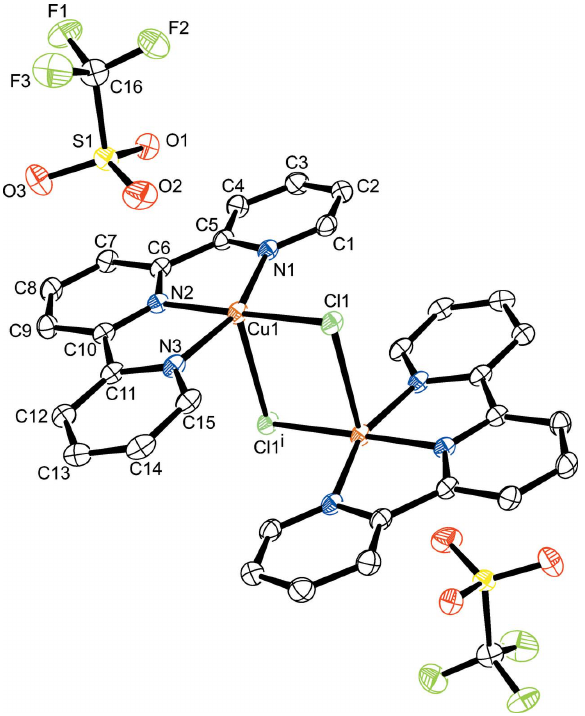
Figure 1 The molecular structure of the title compound with displacement ellipsoids drawn at the 50% probability level; H atoms are omitted for clarity. Symmetry operator for generating equivalent atoms: (i) 1 (cid:5) x , 1 (cid:5) y , 1 (cid:5) z